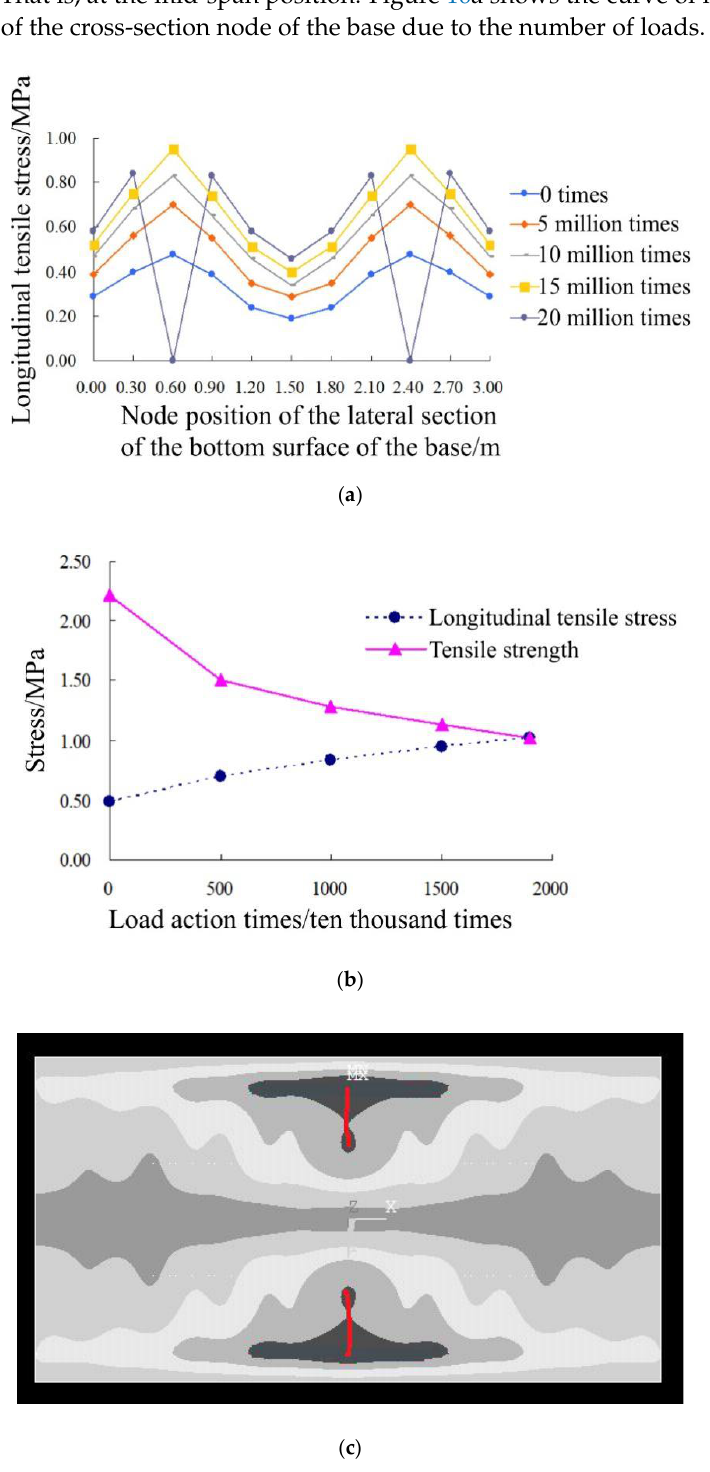
Figure 16. Damage and cracking behavior of SCC. ( a ) Longitudinal tension stress of the mid-span lateral section of the bottom surface of the base plate; ( b ) cracking time at the mid-span part of the bottom surface of the base plate; ( c ) location of cracks in the bottom layer of the base plate. As is shown in Figure 16a, with the increasing number of load actions, the stress of the structural layer gradually increased. Before the application of 5 million times loads, the longitudinal tension stress of the base changed significantly. On average, the stress